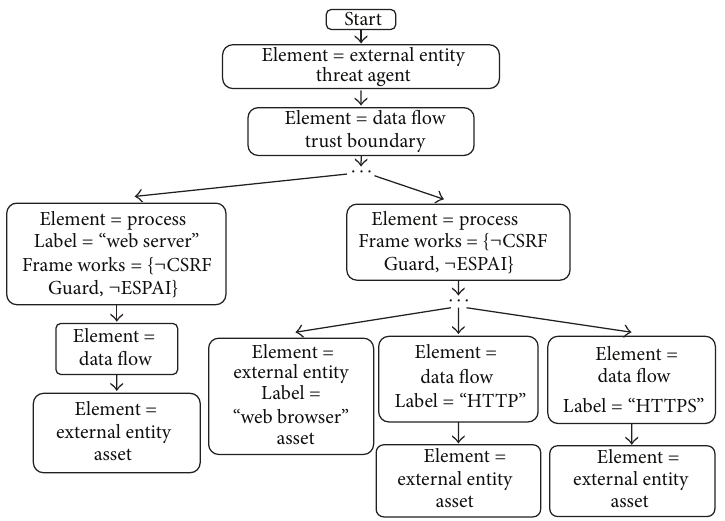
Figure 4: Identification graph of CSRF